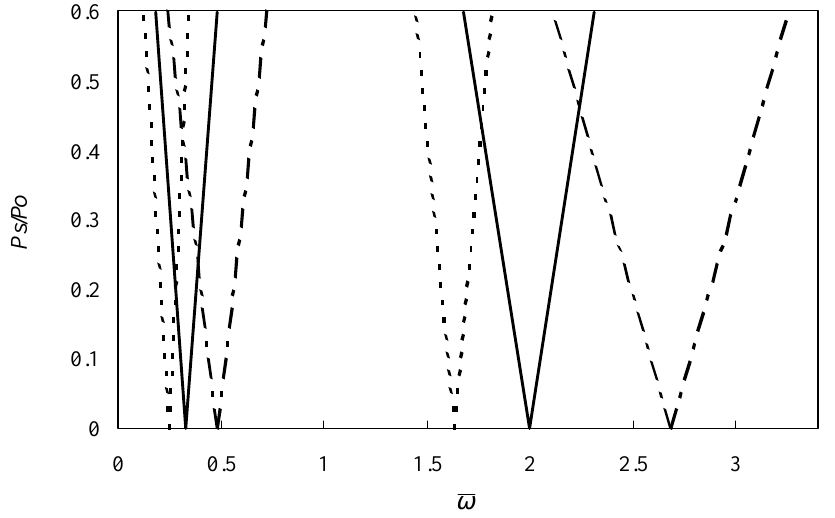
Fig. 6. First two instability regions for a rotating beam with double cracks at x cmean = 0 . 5 L , Ω = 1 and a/h = 0 . 5 . ‘-.-.-’ L = 0 . 8 m, ‘–’ L = 1 . 0 m, ‘- - -’ L = 1 . 2